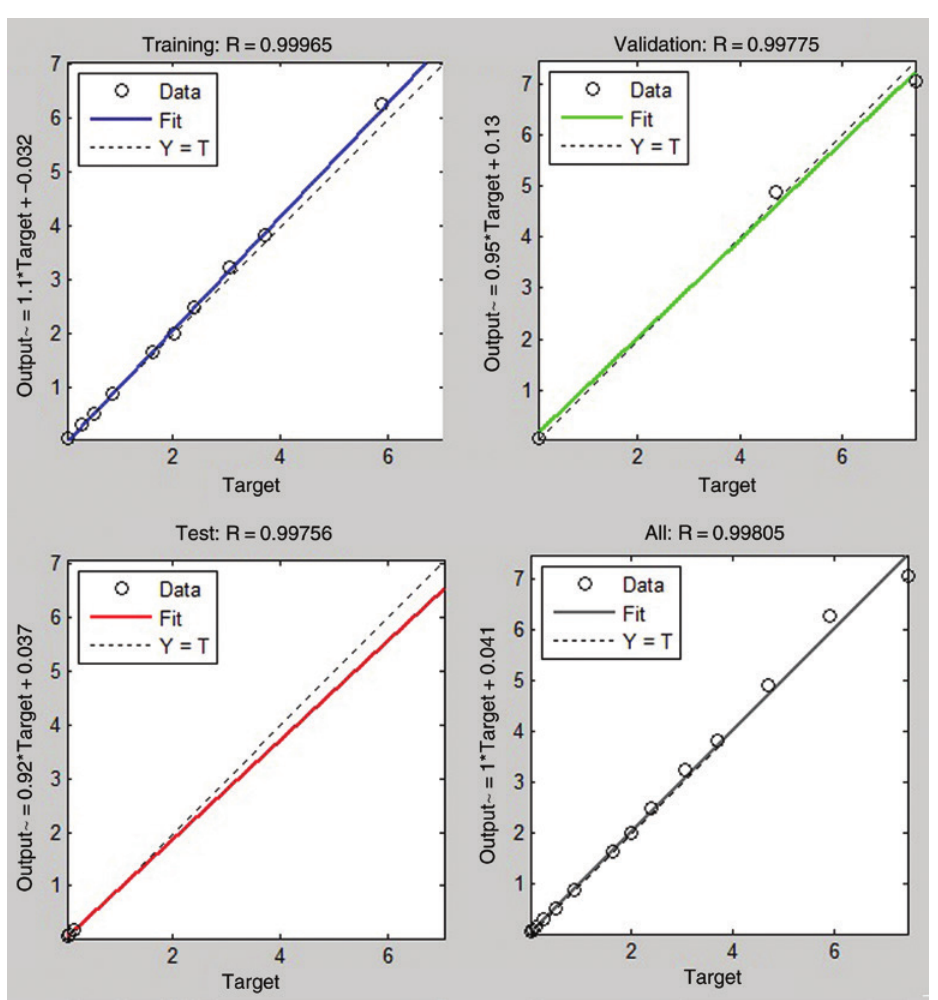
Figure 11: Training and testing of expert